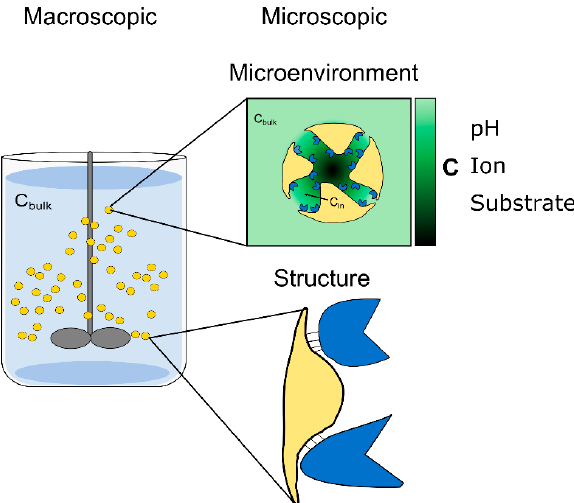
Figure 1. Factors influencing the macroscopic behavior of immobilized enzymes. The formation of a distinct microenvironment in porous enzyme supports is shown. The analyte’s concentration in the well-mixed liquid bulk (C bulk ) often differs from the concentration inside the carrier, referred to as the internal milieu (C in ). Spatially resolved measurements are needed to obtain the full internal profile of C in , represented by the light-to-dark green scale. Enzyme binding to the solid surface potentially alters the protein structure. The figure was adapted from reference [14] with permission from Elsevier. The internal milieu for immobilized enzymes is affected by two factors in particular. Firstly, there is solute partitioning between the liquid phase and the solid phase of the carrier. The partitioning is due to the chemical properties of the solid material (e.g., hydrophobicity and charge), creating a distinct surface-near environment with respect to polarity, dielectric and ionic strength [5,6,21,22]. Secondly, there is the interplay between reaction and diffusion. Mass transfer by diffusion occurs from the liquid bulk to the surface of the carrier and from the surface into the pores of the particle. When diffusion is not much faster than reaction, gradients in the substrate and product concentration arise between the bulk and the carrier. At steady state, therefore, the chemical milieu in bulk and in particle is different [12,14]. Enzyme performance is influenced by the changes in microenvironment (Figure 1). A key performance parameter is the catalytic rate (activity). This depends on substrate and product concentration, as well as on pH and ionic strength. Besides the kinetic effect, changes in the critical concentrations can affect the reaction equilibrium constant and the effective mass-action ratio in the solid particle. Another important enzyme parameter is stability.